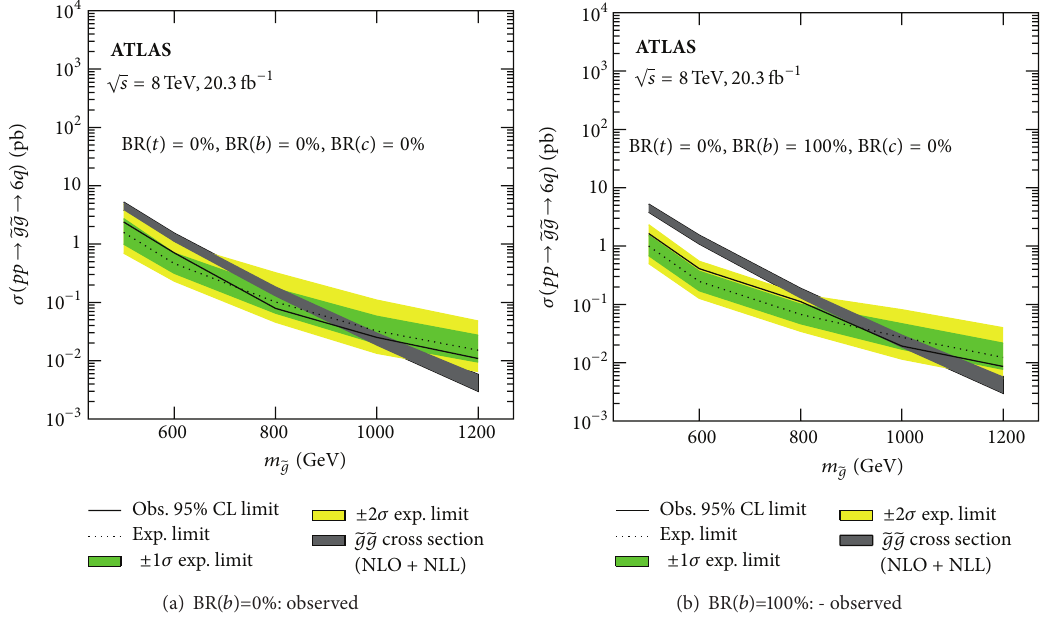
Figure 12: Observed mass exclusions at the 95% CL for BR( 𝑏 ) = 0% (a) and BR( 𝑏 ) = 100% (b) (from